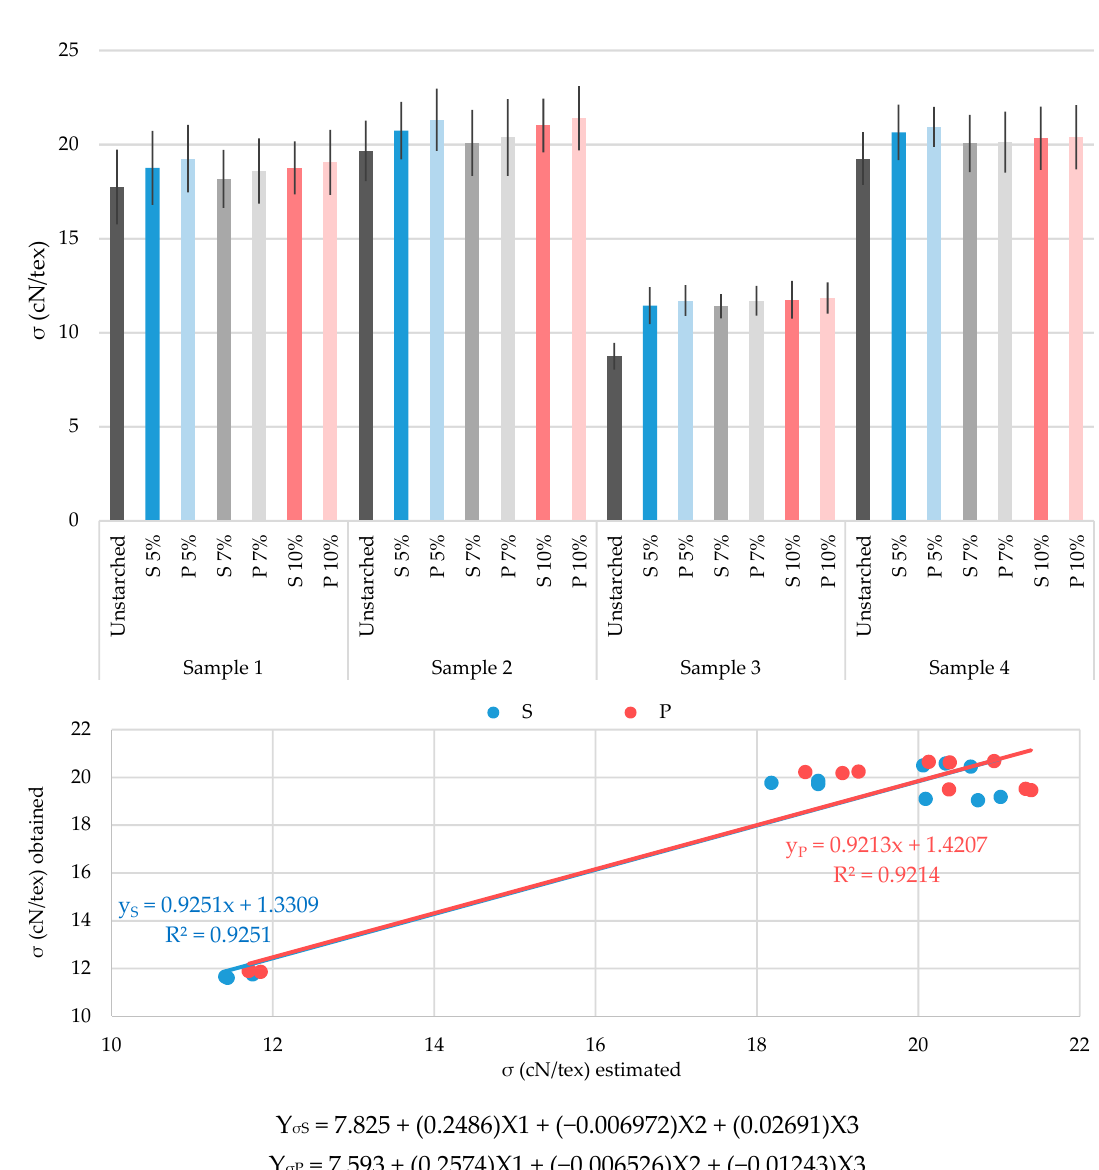
Figure 4. Diagram of tenacity ( σ ) of the tested yarns: unstarched yarns and yarns starched by standard and prewetting processes, with 5%, 7% and 10% starch mass concentration.